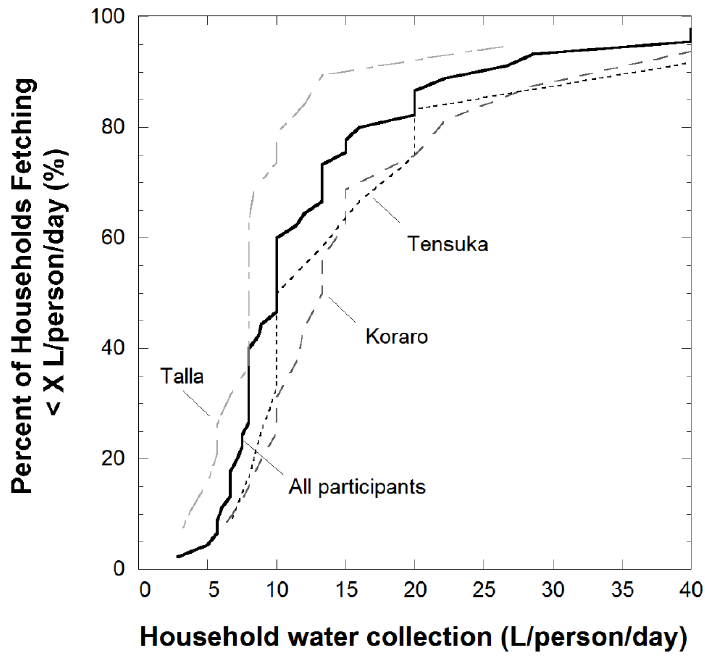
Figure 3. Cumulative distribution function for the volume of water fetched for each Kushet and for all participants.